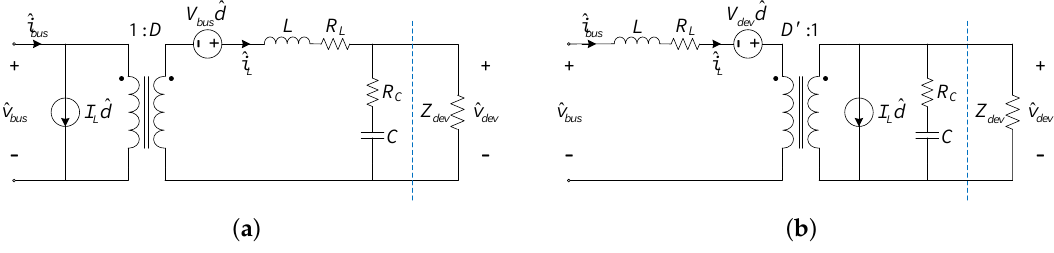
Figure 4. Averaged small-signal circuit of a device-regulating converter when it operates in ( a ) the buck mode or in ( b ) the boost